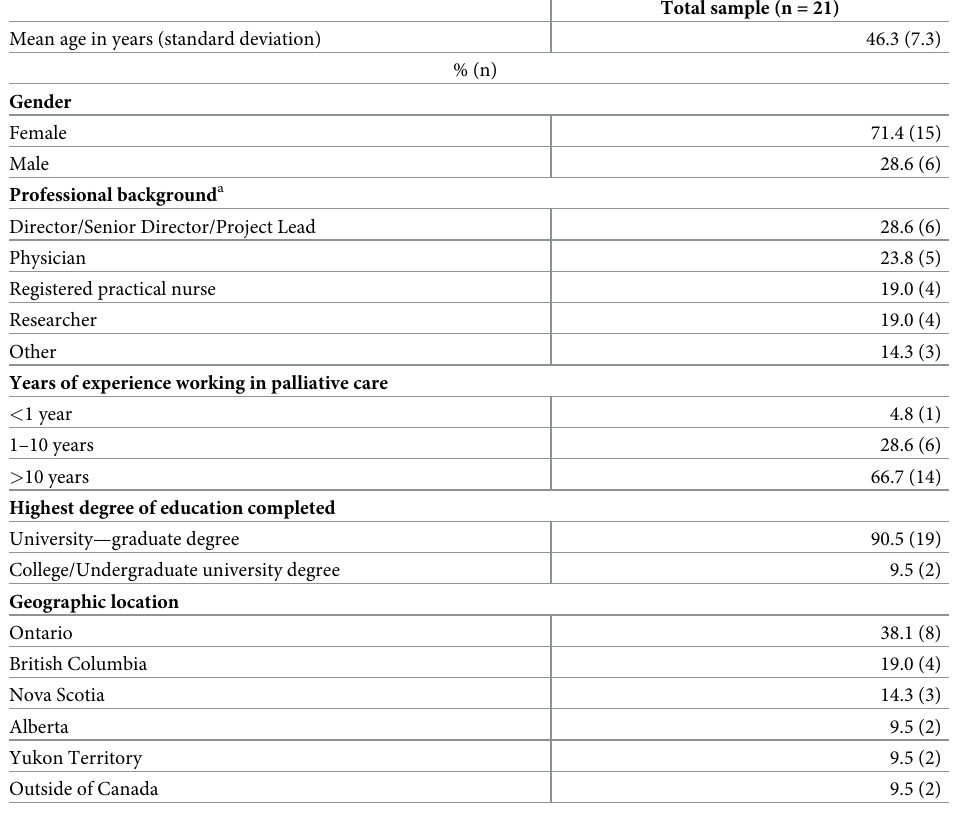
Table 2. Demographic characteristics of individuals who participated in the expert